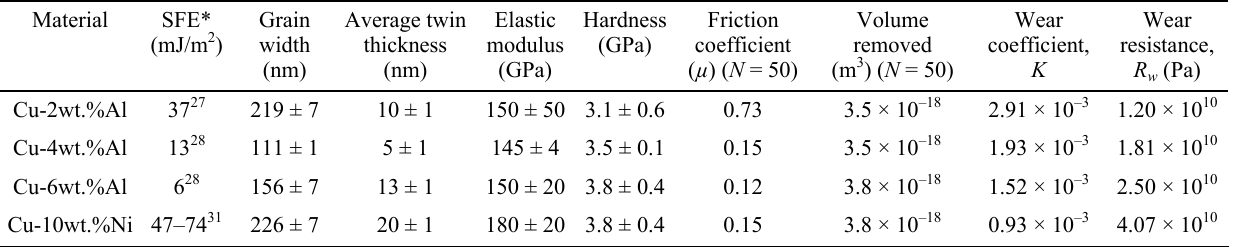
Table 1 Summary of sliding tests results for Cu alloys with microstructure and